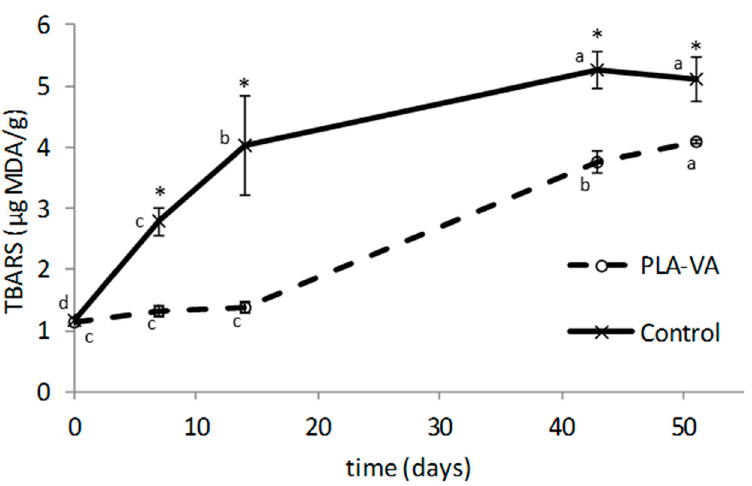
Figure 4. Lipid oxidation during refrigerated storage of salami. (Different letters within a batch indicate significant differences ( p < 0.05) among sampling times. *Indicates significant differences between batches within a sampling time).